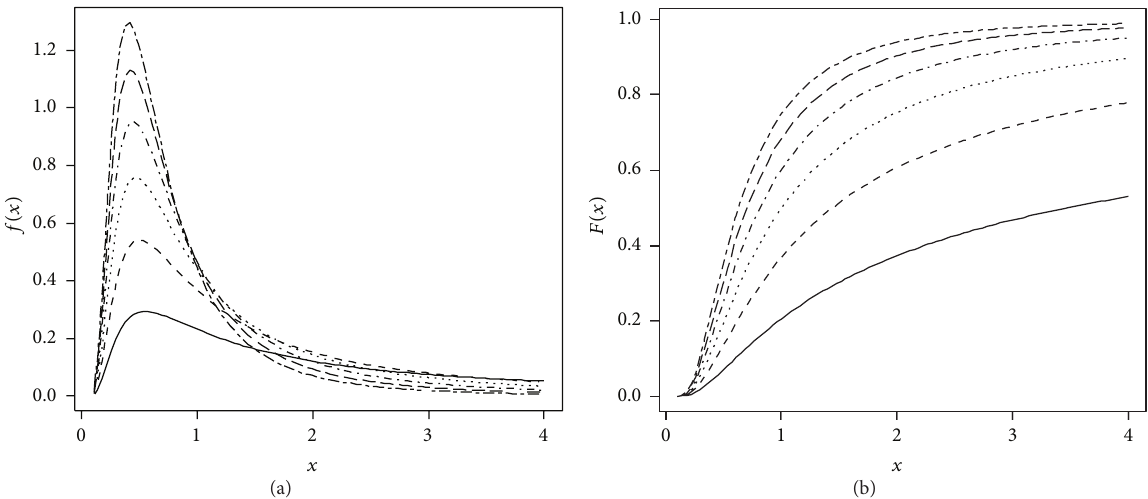
Figure 1: Possible shapes of the pdf 𝑓(𝑥) (a) and cdf 𝐹(𝑥) (b) of the EG type-2 distribution for fixed parameter values of 𝜙,𝜃 = 1 and selected values of 𝛼 parameter. 𝛼 = 0.5 (solid lines), 𝛼 = 1 (dashed lines), 𝛼 = 1.5 (dotted lines), 𝛼 = 2 (dot-dashed lines), 𝛼 = 2.5 (long dashed lines), and 𝛼 = 3 (two dashed lines).